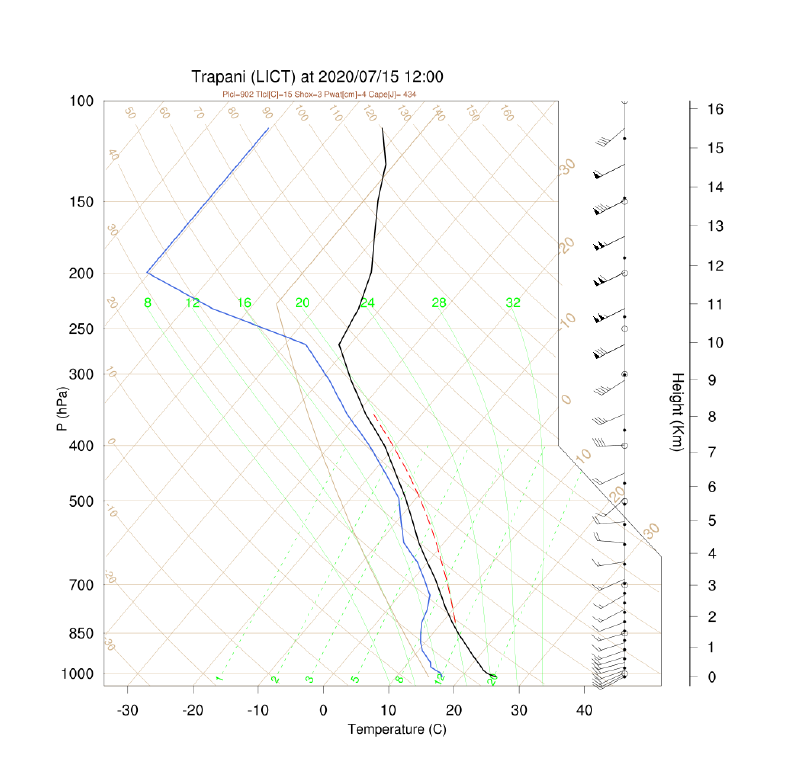
Figure 13. Skew-T profile as simulated by the WRF 1 km model for the grid location corresponding to Trapani Birgi at 12:00 UTC of 15 July 2020.